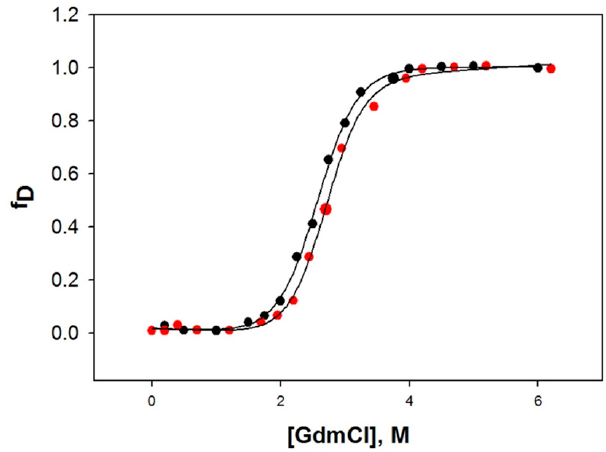
Figure 7. Stability of HSA in presence and absence of cyclobenzaprine. GdmCl-induced denaturation